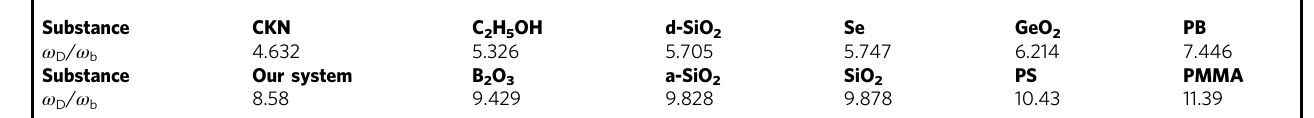
Table 2 Comparison of ω D / ω b Substance